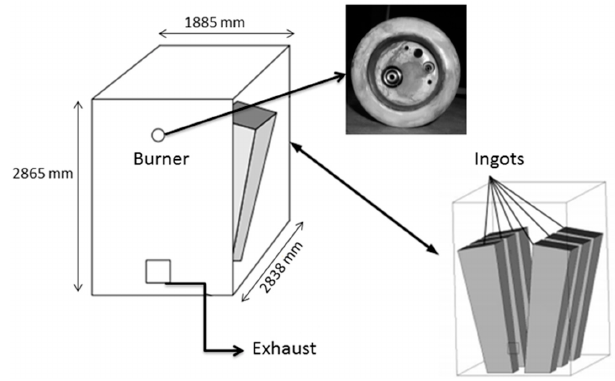
Figure 2. The insertion of the ingots inside the soaking pit furnace.